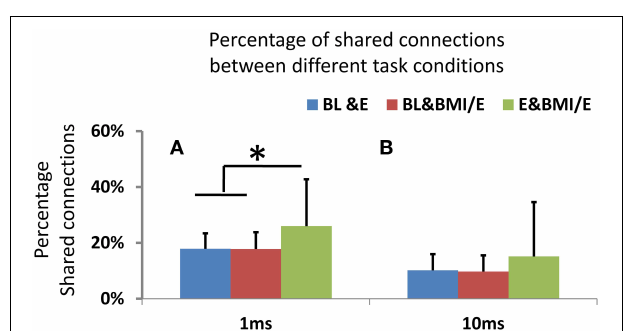
that rats in BMI/E offset load while preserving more normal pelvic height compared to load alone (Song and Giszter, 2011).